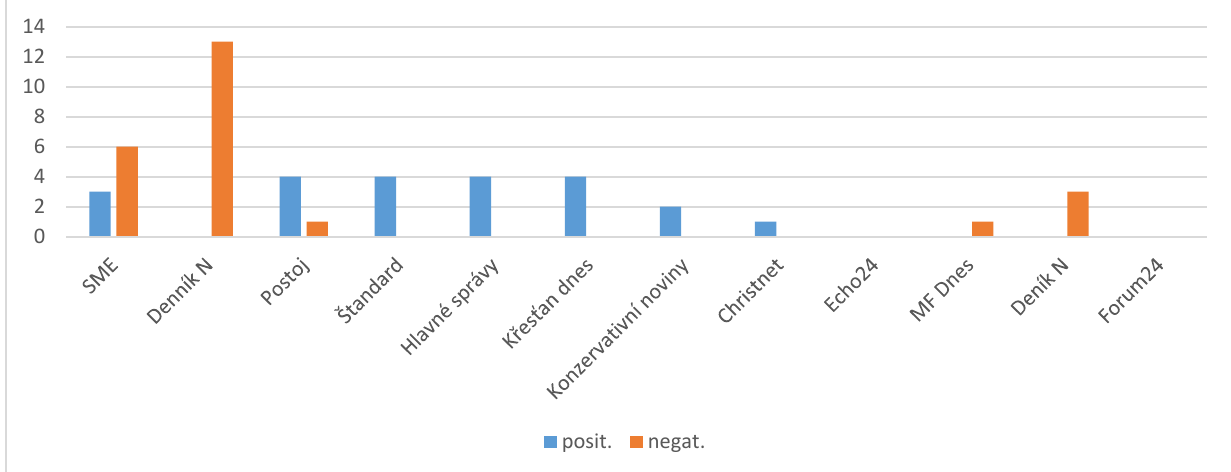
Figure 5. Occurrences of ‘safety of churches’ as an argument (A4).